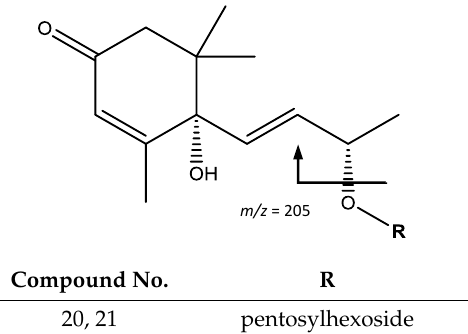
Figure 9. Chalcones structure and main fragments.